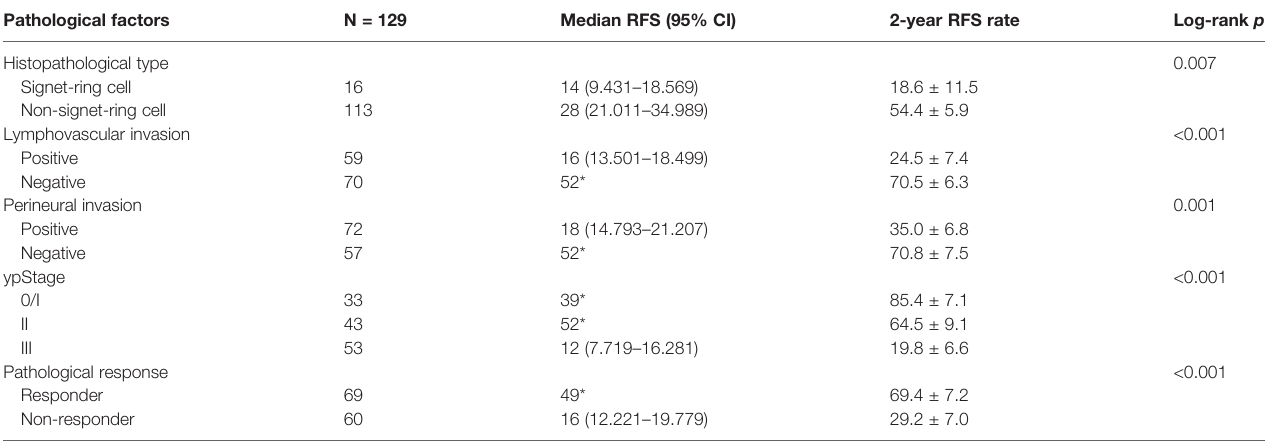
TABLE 6 | Kaplan – Meier survival analysis according to pathological factors for predictors of